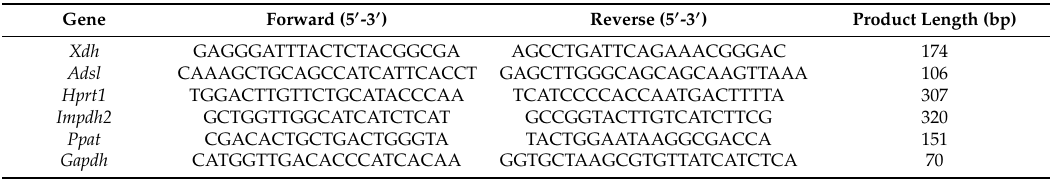
Table 5. Sequences of the primers used for